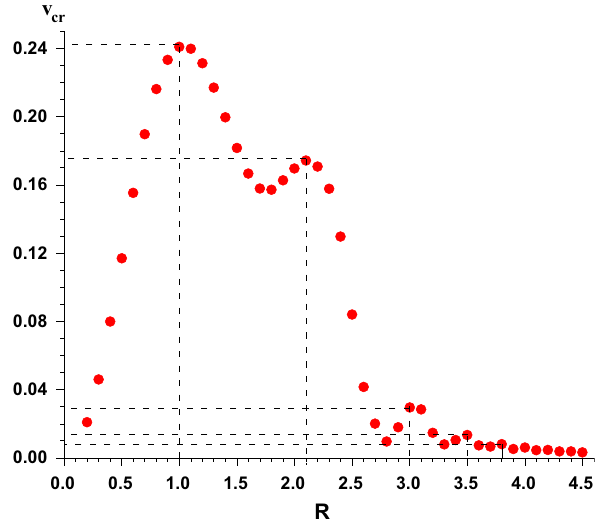
Fig. 6 The critical velocity v cr as a function of the parameter R . (The initial half-separation is ξ = 20 in these calculations) Table 1 Positions of the local maxima of the dependence v ( R ) , which is shown in Fig. cr